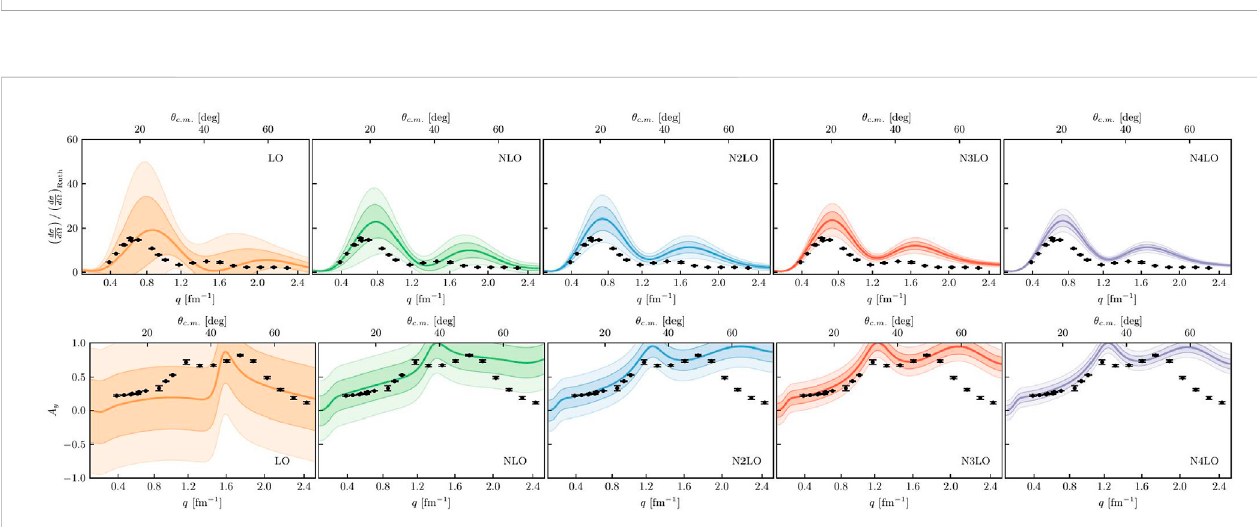
FIGURE 10 Differential crosssectiondividedbytheRutherfordcrosssection(top)andanalyzingpower(bottom) forprotonscatteringfrom 16 Oat100 MeV.The fi rst three columns are the same as the second rows of Figures 8, 9. The additional two rightmost panels are inconsistent calculations with use up to N2LO in the structure calculations and up to N3LO (fourth column) or N4LO ( fi fth column) in the reaction calculation. Due to the inconsistency of the calculation the uncertainty bands are not fully realistic. The data are the same as cited in Figures 8,